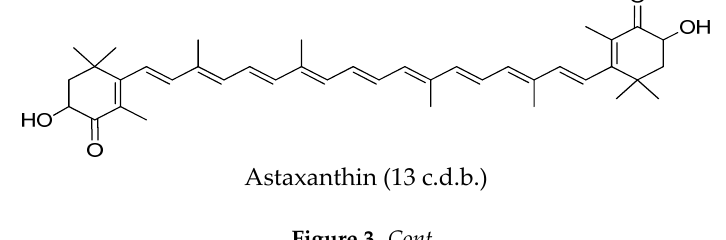
Astaxanthin (13 c.d.b.) Figure 3.